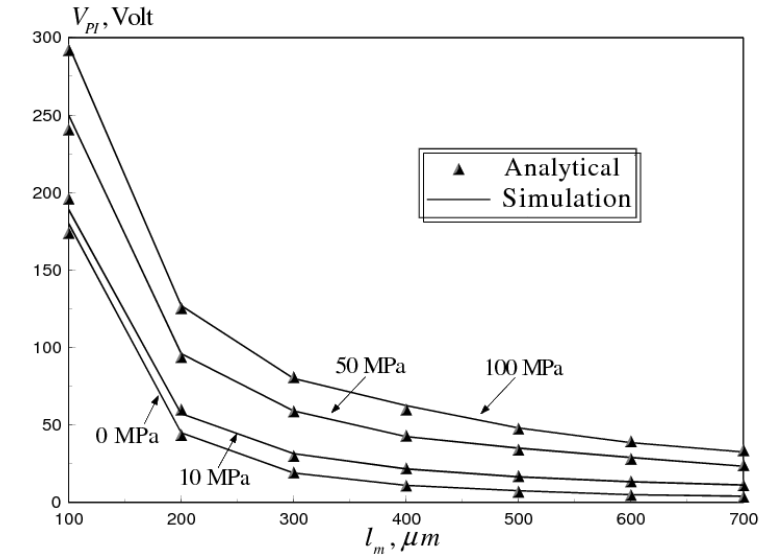
Figure 6. Substructured structural-electrostatic model predictions versus analytical results reported by Pamidighantam et al. [12] of pull-in-voltage versus beam length for fixed- fixed gold beam at different values of microfabrication residual stresses ( W t = 1 µm , g = 2.5 µm , β = 0.4, E = 77 m o PI m